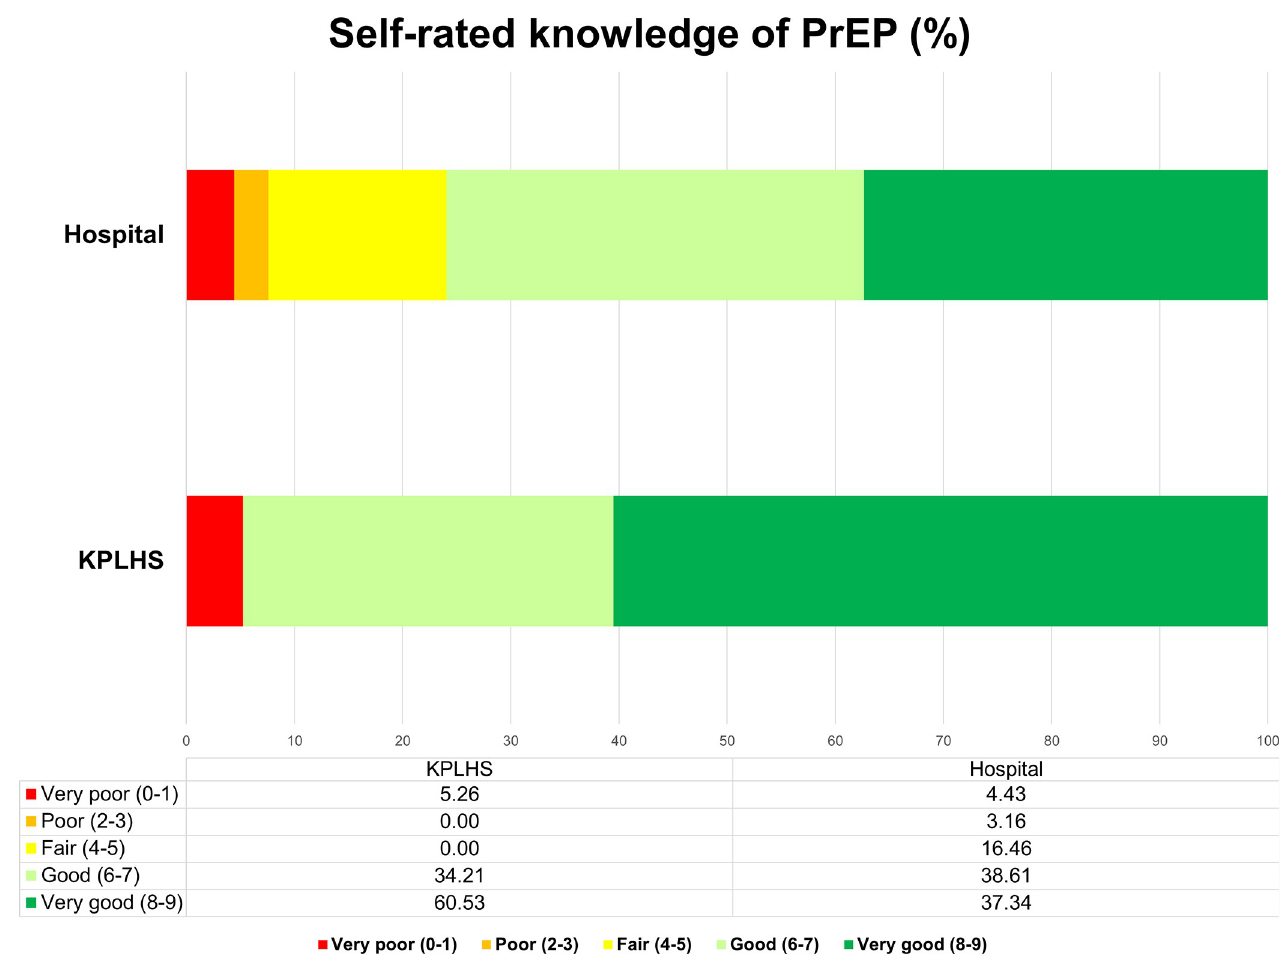
Fig 1. Self-rated knowledge of PrEP by service delivery model (hospital vs.